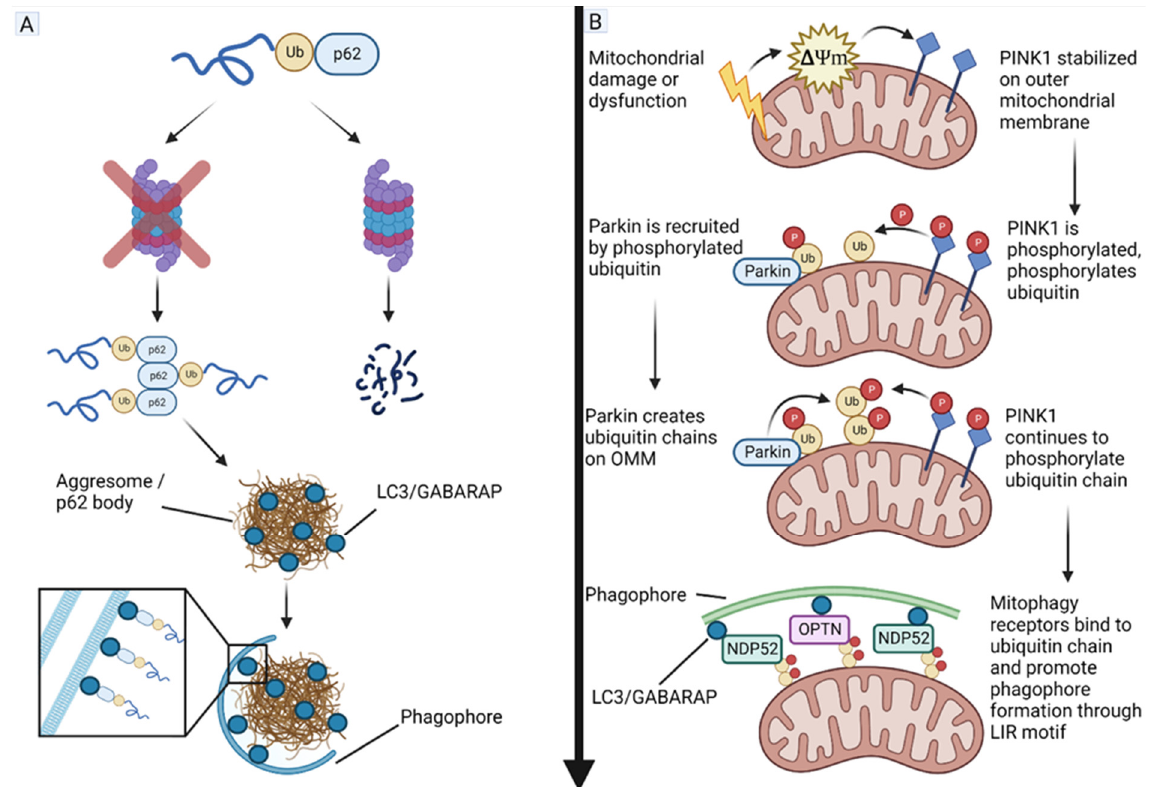
Figure 5. Interactions between the UPS and selective autophagy in GBM. ( A ) Ubiquitinated proteins destined for degradation are bound by SQSTM1/p62. If UPS is functioning at a sufficient level, SQSTM1/p62 will act as a chaperone guiding the substrate into the proteasome. If UPS function is impaired, substrate-bound SQSTM1/p62 will oligomerize forming an aggresome or SQSTM1/p62 body in the cytosol. The SQSTM1/p62 body is joined by microtubule-associated proteins 1A/1B light chain 3B (hereafter referred to as LC3)/gamma-aminobutyric acid receptor-associated protein (GABARAP) via its LC3-interacting region (LIR) motif, which subsequently attracts the autophagy machinery to facilitate degradation. Protein aggresomes can become cytotoxic if allowed to accu- mulate. ( B ) Selective autophagy of mitochondria (mitophagy) is normally active at a low level in most cells but becomes activated when mitochondria become damaged (such as mtDNA damage from radiation) or otherwise dysfunctional. Mitochondria respond to damage through disruption of mitochondrial membrane potential ( ΔΨ m), allowing PTEN-induced kinase 1 (PINK1) to accu- mulate on the outer mitochondrial membrane (OMM). PINK1 proceeds to phosphorylate ubiquitin (Ub), attracting Parkin (a 465-amino acid residue E3 ubiquitin ligase), which is then also phosphor- ylated and activated. Parkin then begins building ubiquitin chains on OMM proteins, which PINK1 continues to phosphorylate. The phosphorylated ubiquitin chains then recruit mitophagy receptors including nuclear dot protein 52 (NDP52) and optineurin (OPTN). These mitophagy receptors then bind to LC3/GABARAP via their LC3 interacting region (LIR) motif. LC3/GABARAP then recruits autophagy initiation machinery such as the Unc-51 Like autophagy activating Kinase 1 (ULK1) to begin forming a phagophore around the cargo leading to degradation.